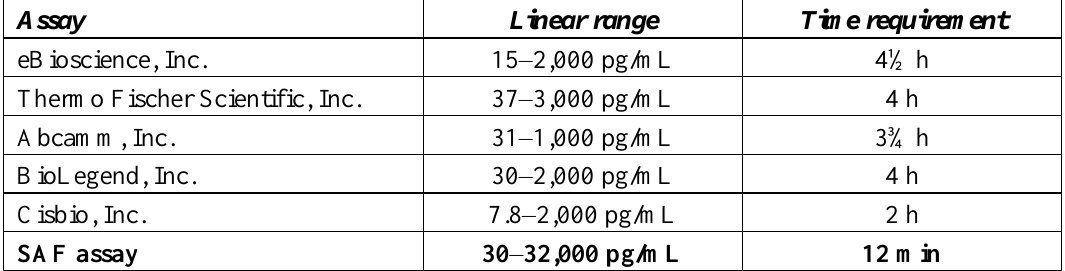
Table 1. Comparison between the SAF assay and the specifications of several commercially available ELISA kits for mouse